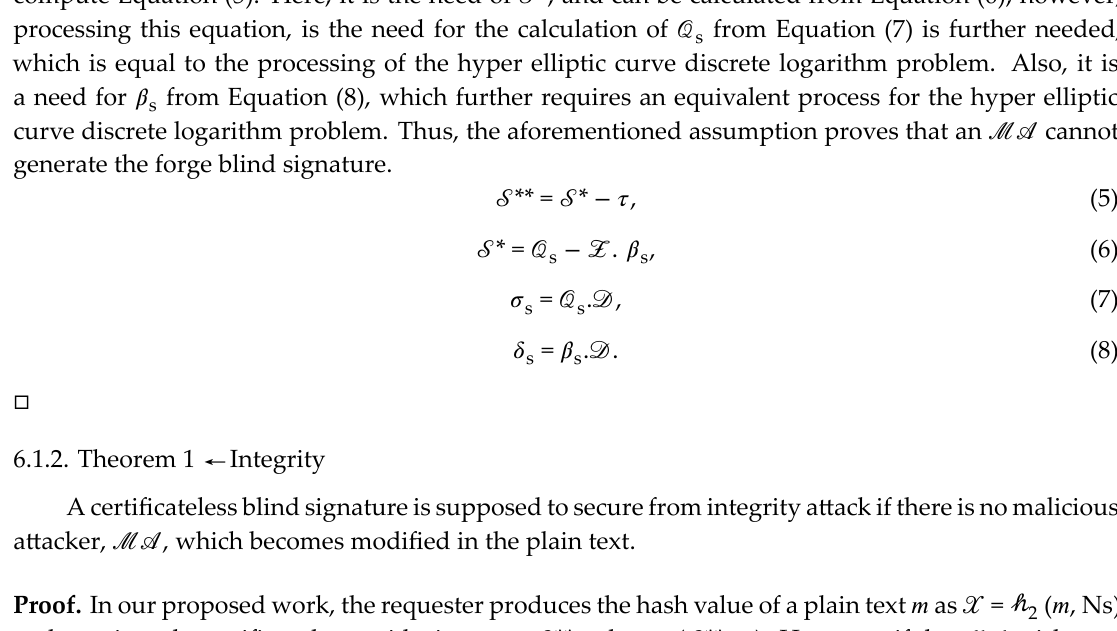
Table 1. Notations used in proposed